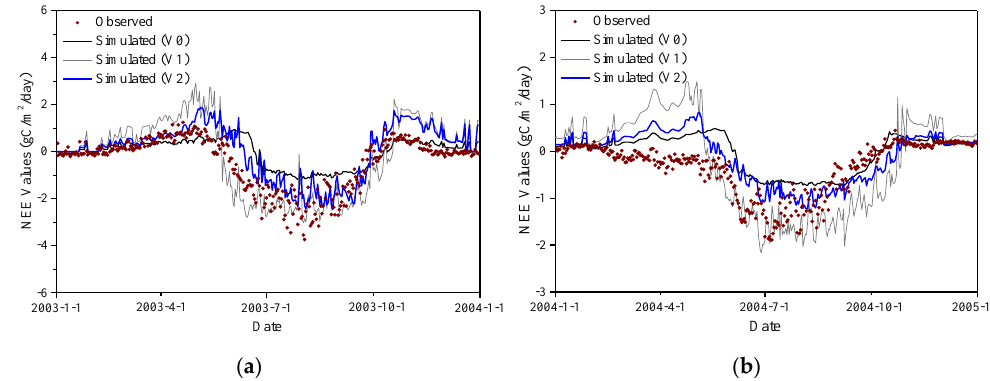
Figure 5. Comparisons between NEE measured by EC technique and NEE simulated by the version of V0, V1, and V2 for the calibration year. ( a ) Haibei Station (alpine meadow); ( b ) Damxung Station (alpine steppe).